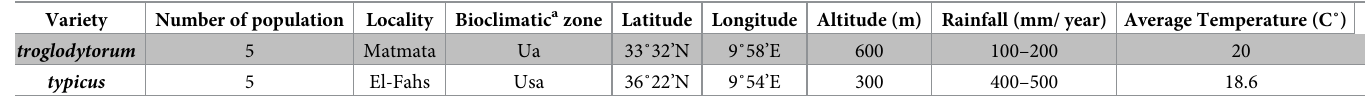
Table 1. Location, main ecological traits of the analysed populations of Rosmarinus officinalis L. Variety